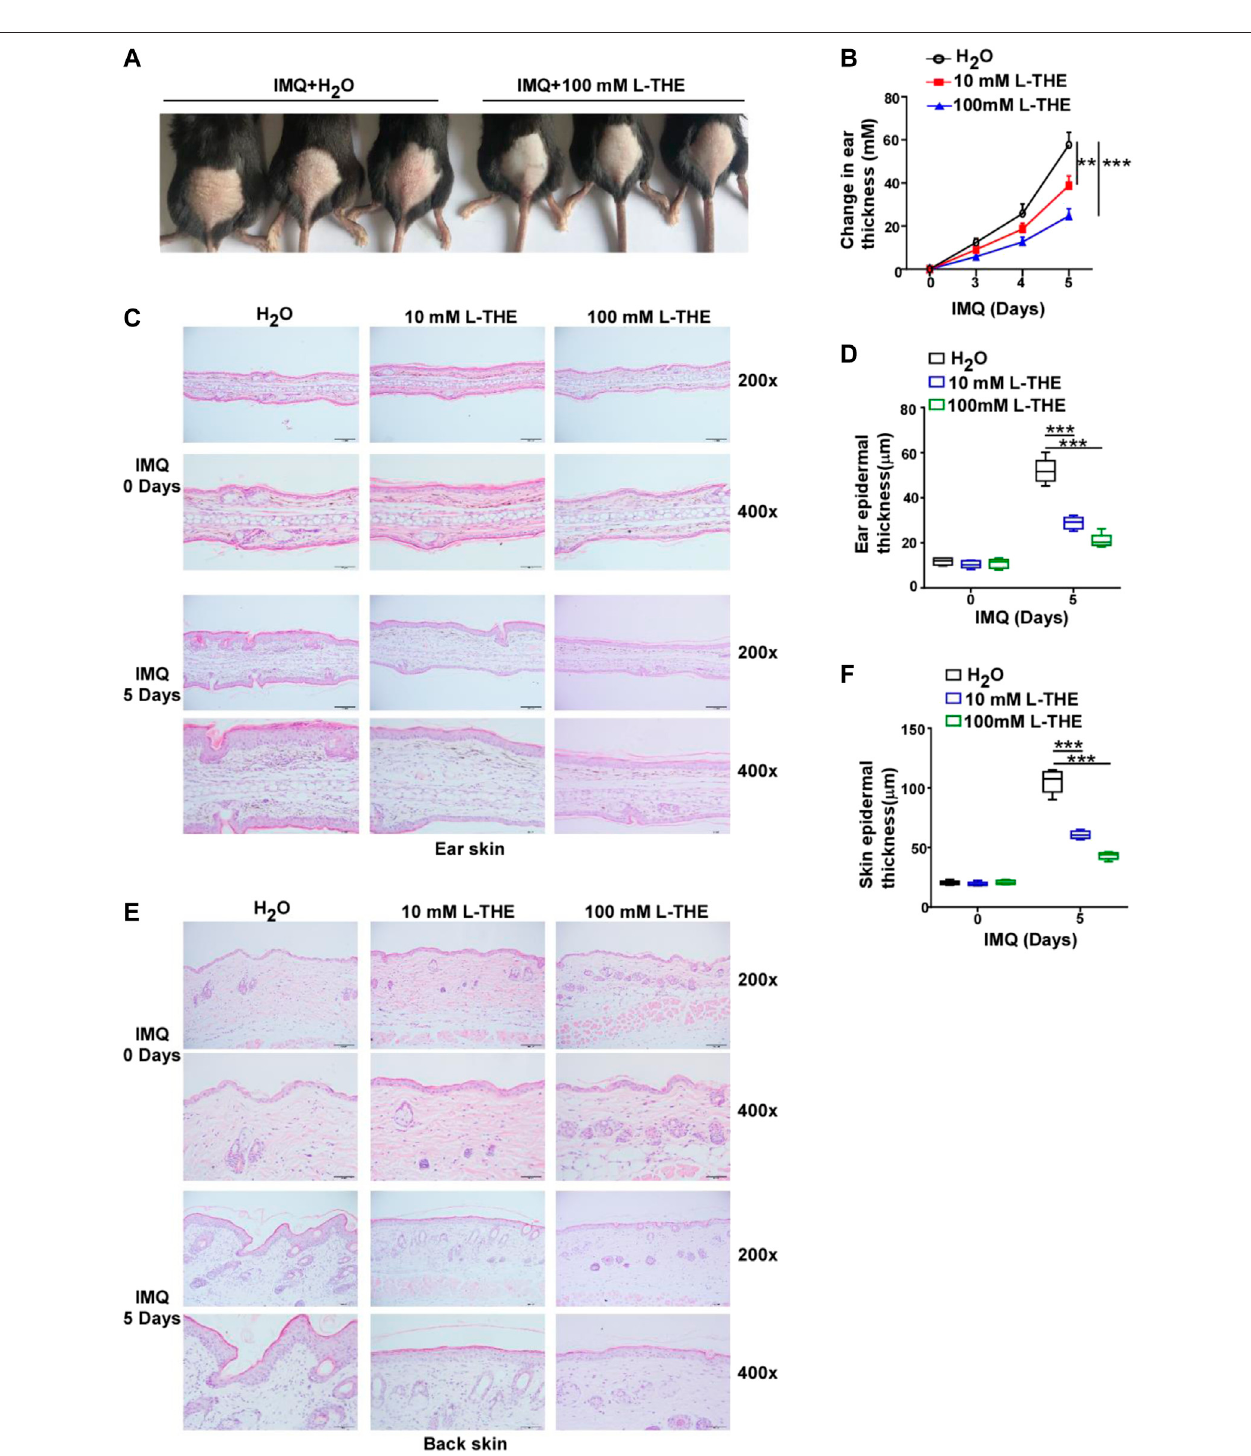
FIGURE1| L-THEdecreasesepidermalthicknessinmicewithIMQ-inducedpsoriasislikeskinin fl ammation. (A) C57BL/6mice( n (cid:1) 6pergroup)weresubjectedto a daily topical dose of IMQ cream on the shaved back or ear for fi ve consecutive days, and were topical applied with 10 mM or 100 mM L-THE on the skin for twice per day. (B) MiceearthicknesswasmeasuredrelativetothecontralateralearfromIMQ-inducedpsoriasismicetreatedwithL-THEorH 2 O. (C) H&Estainingearskinsections obtainedfromIMQ-inducedpsoriasismicetreatedwithL-THEorH 2 Ofor5 days. (D) Theearepidermalthicknesswasmeasuredin (C) bythesoftwareImageJ. (E) H&E staining back skin sections obtained from IMQ-induced psoriasis mice treated with L-THE or H 2 O for 5 days. (F) The ear epidermal thickness was measured in (D) by the software ImageJ. Data is representative of three independent experiments. p values are determined by two-way ANOVA. ** p < 0.01, *** p < 0.001.